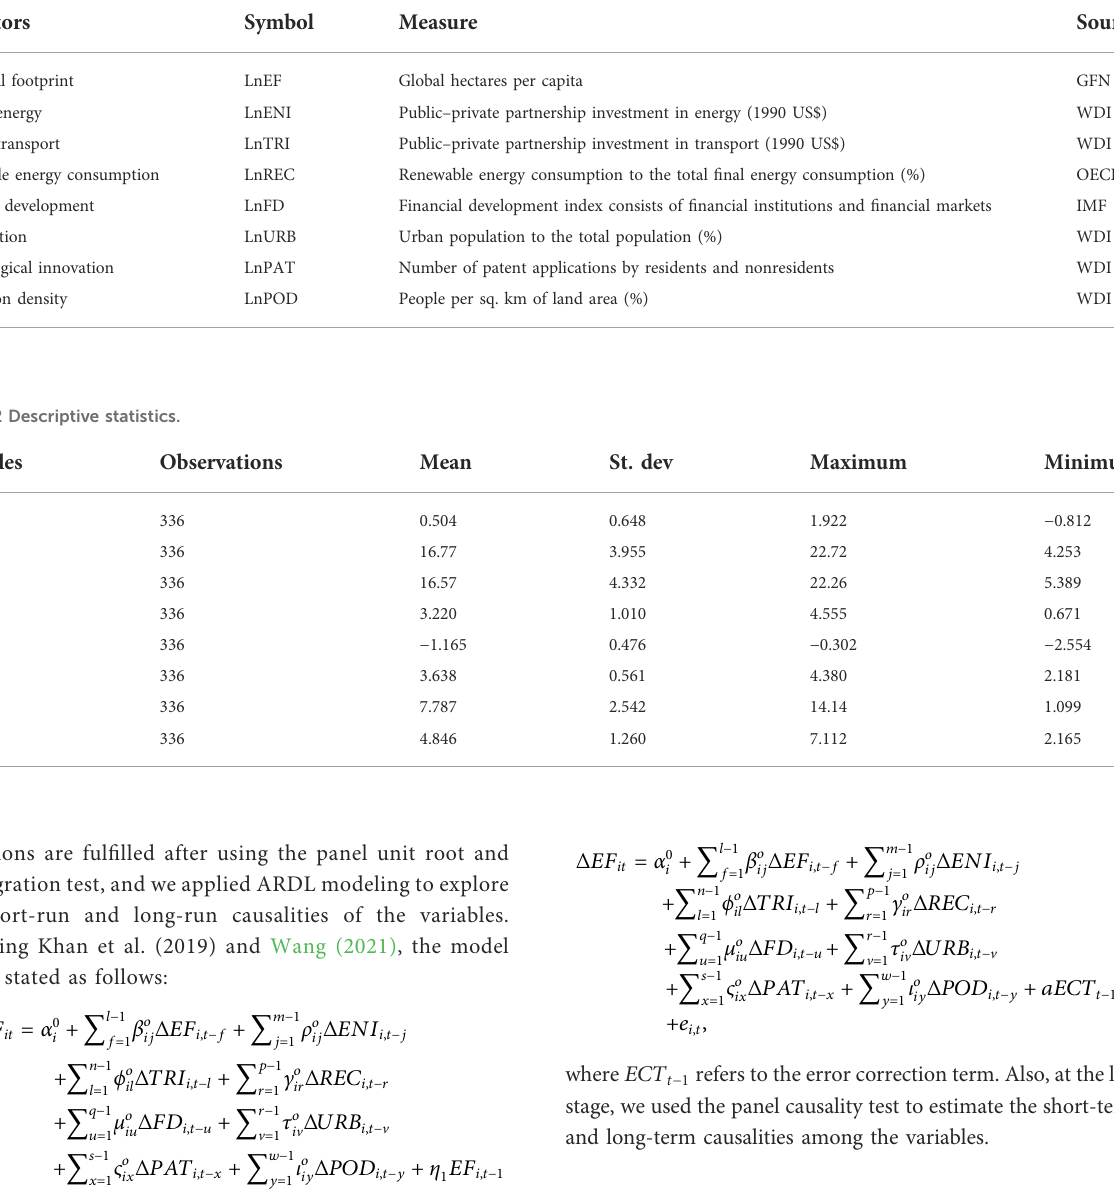
TABLE 1 Description of indicators.